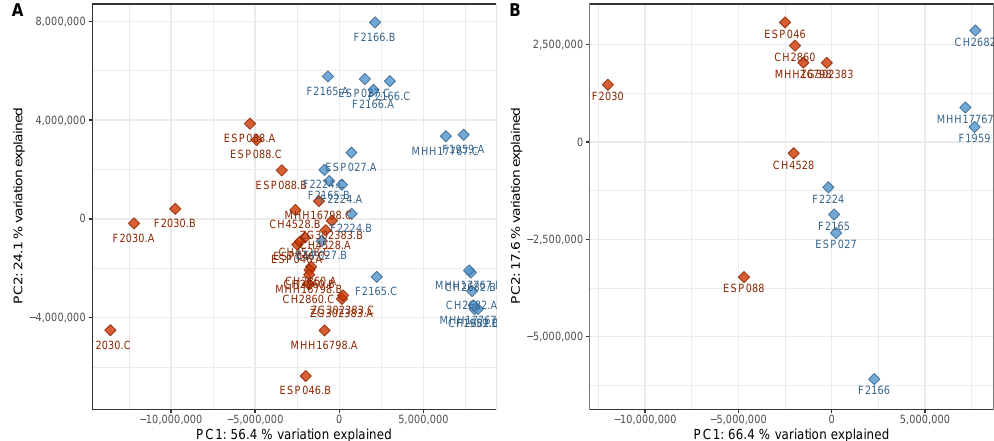
Figure 1. Principal component analysis (PCA) scores plot of the discovery data set. ( A ) All samples in the discovery data set were subjected to a principal components analysis with centering and rotation of the variables. The samples were plotted using principal components 1 and 2 as coordinates. A good separation of the groups is visible, predominantly in principal component 1, which explains 56% of the variation in the data set. ( B ) The data from the triplicate samples was averaged per strain and subjected to a PCA as described above. The separation is very similar to the data on the sample level. A clear separation can be achieved by considering both principal components 1 and 2. Red—virulent cluster A strains, blue—avirulent cluster B